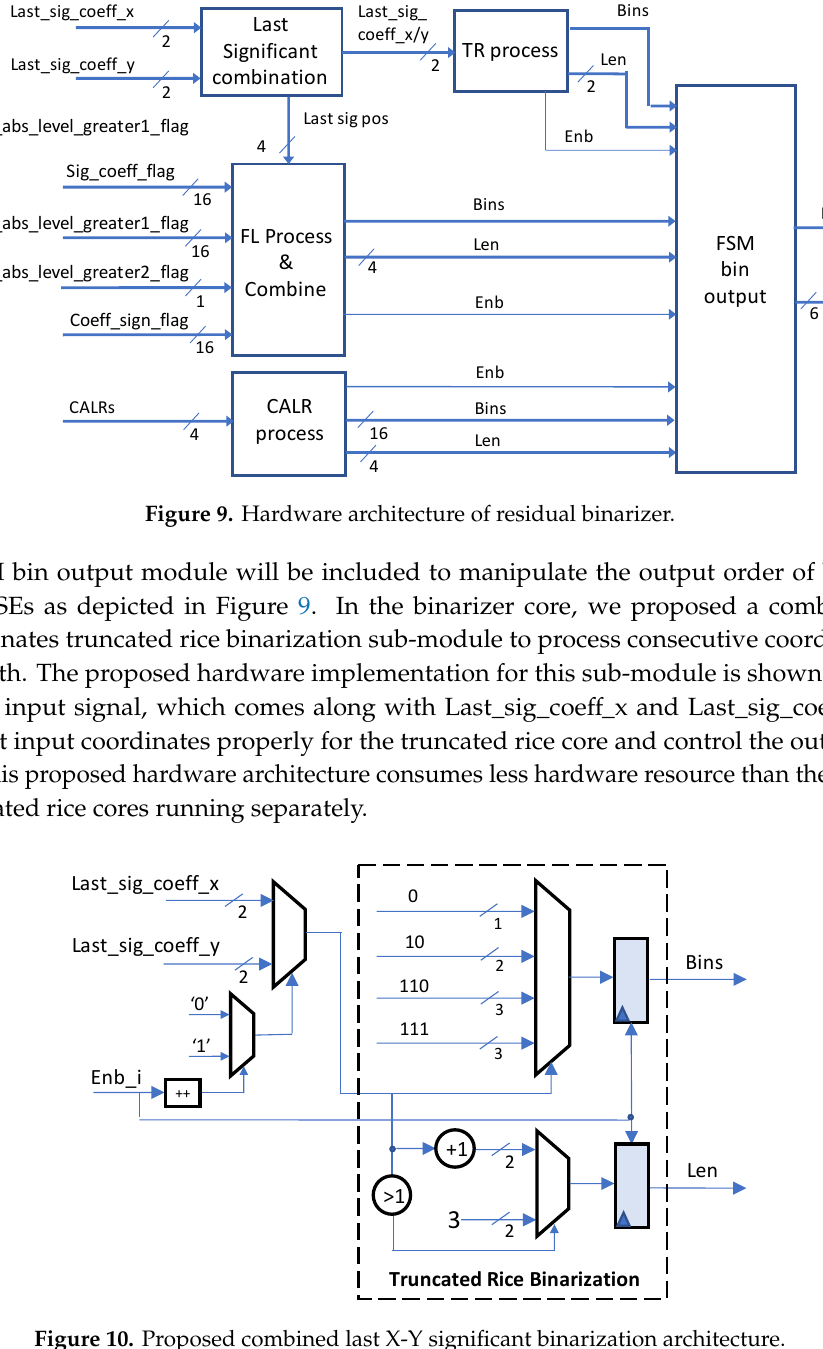
Figure 10. Proposed combined last X-Y significant binarization architecture.